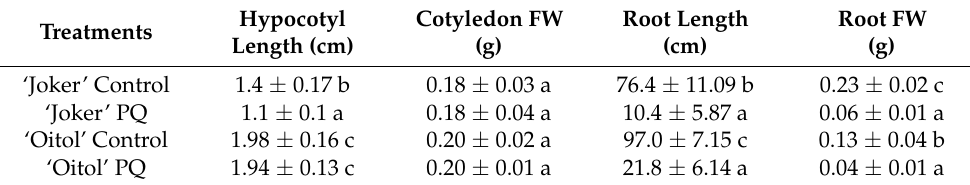
Table 1. Effect of Paraquat dichloride on seedling characteristics of two cucumber hybrids.